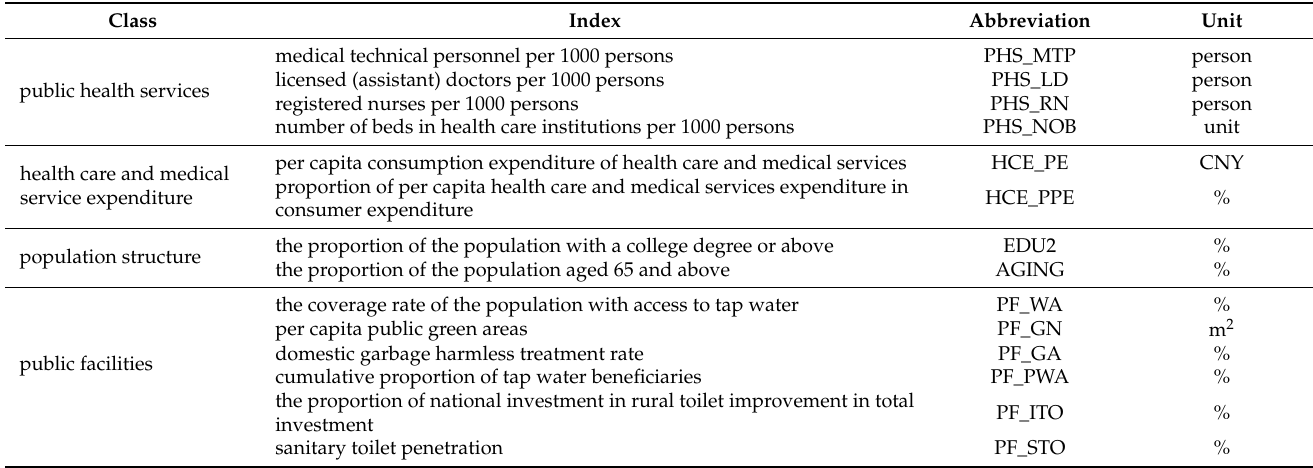
Table 2. Provincial